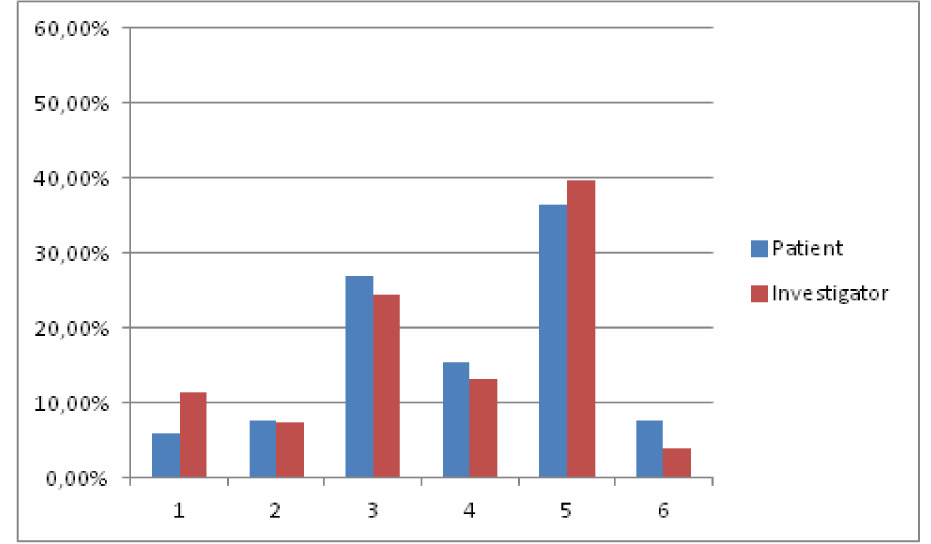
Figure 3. The satisfaction with treatment according to the Medication Satisfaction